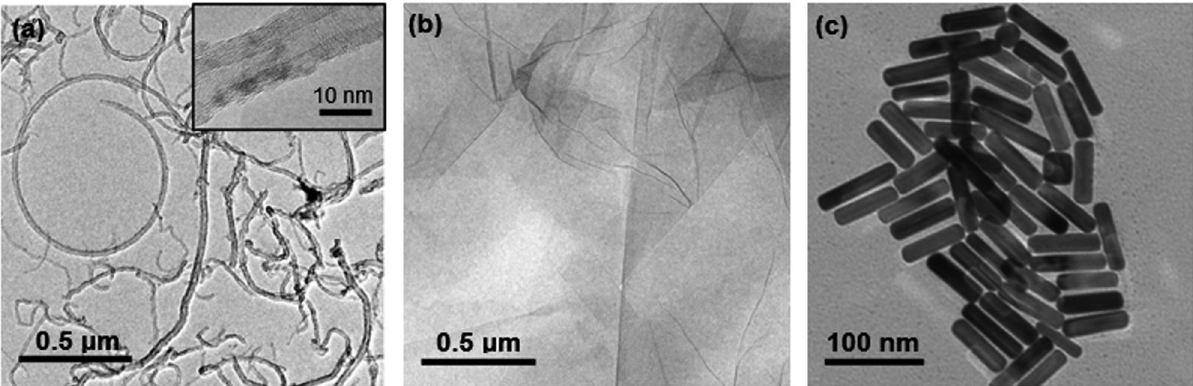
Figure 2: TEM images of the as - prepared ( a ) MWCNTs; ( b ) GO and ( c )